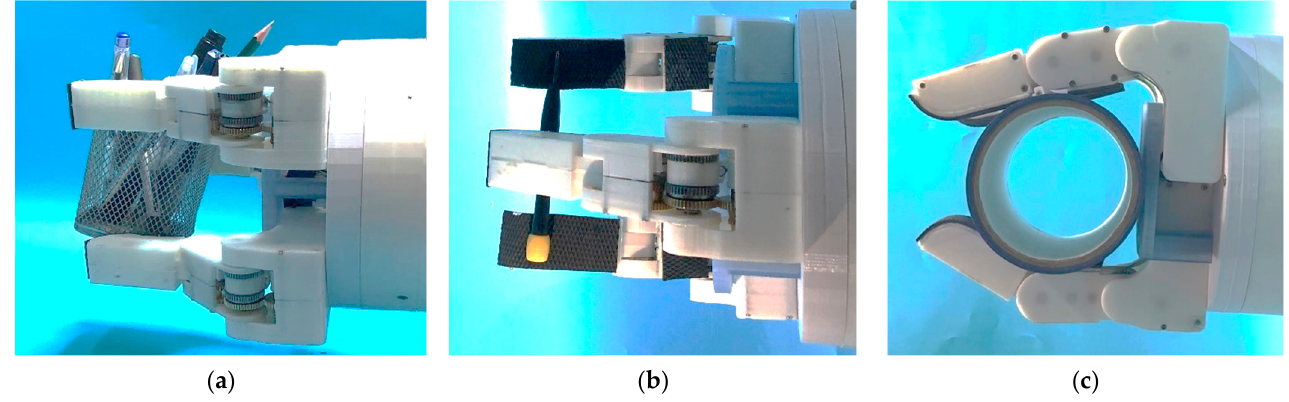
Figure 23. Grasping experiments scenarios: ( a ) Grasping experiment with parallel mode; ( b ) Grasping experiment with coupled mode; ( c ) Grasping experiment with PASA mode and COSA